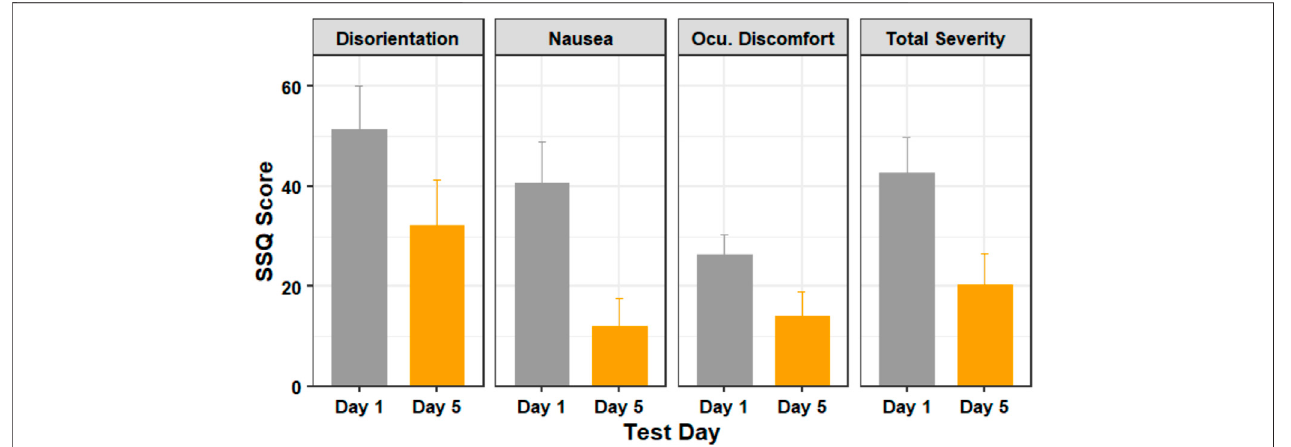
FIGURE 4 | The SSQ subscores of participants in days 1 (before training) and 5 (after training). Figure shows mean and standard error.